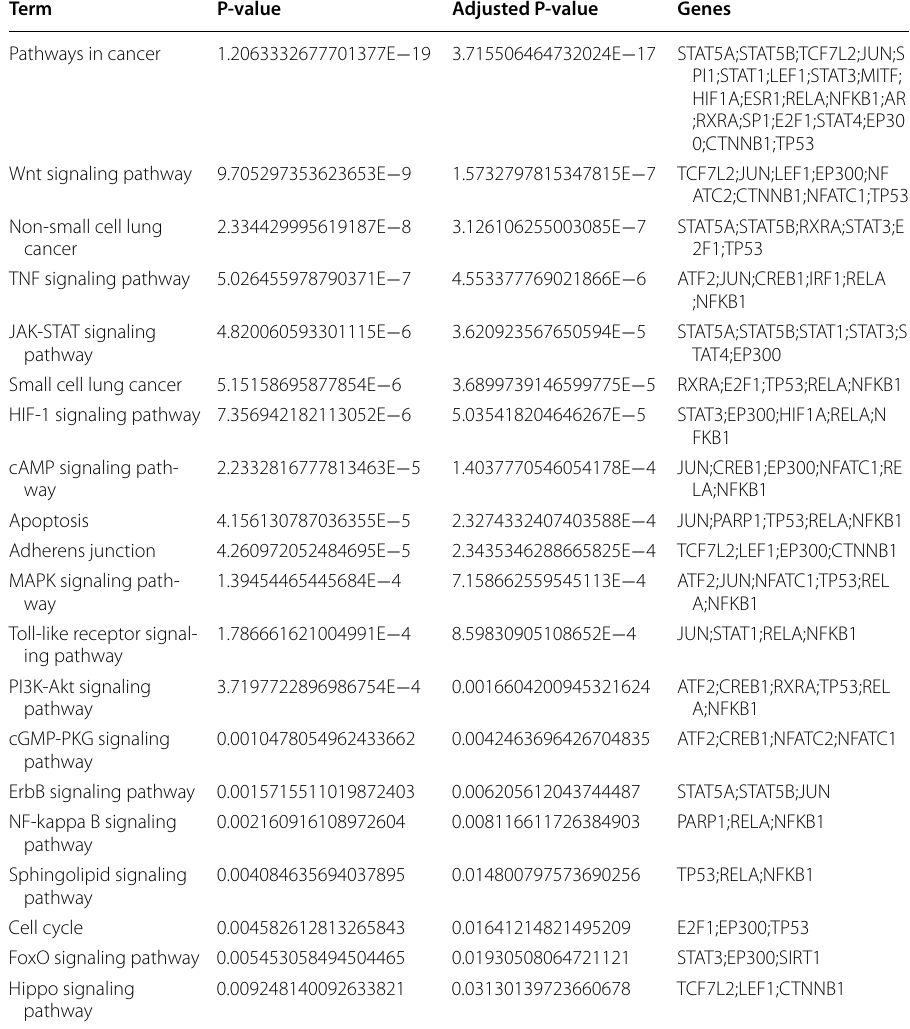
Table 7 The annotations of transcription factors regulating the harvested genes from the